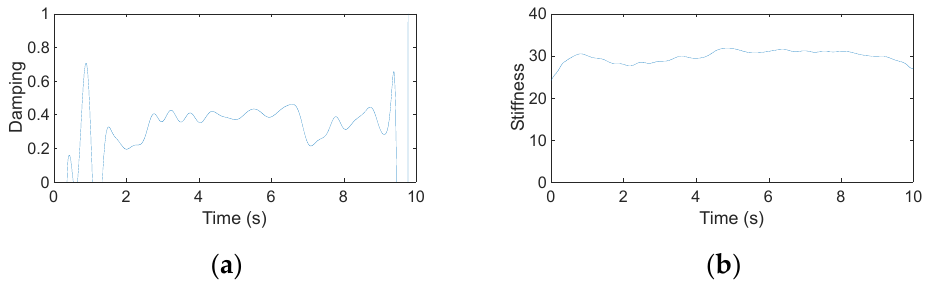
Figure 19. Identified structural property: ( a ) structure damping; ( b ) structure stiffness. For parameter identification of viscous damping, a similar procedure is performed for the bridge specimen with the finite element model. The seismic behavior of the damper is shown in Figure 20, and its nonreality is observed with a full force-displacement cycle, where the maximum design damping force of 6 kN is reached.